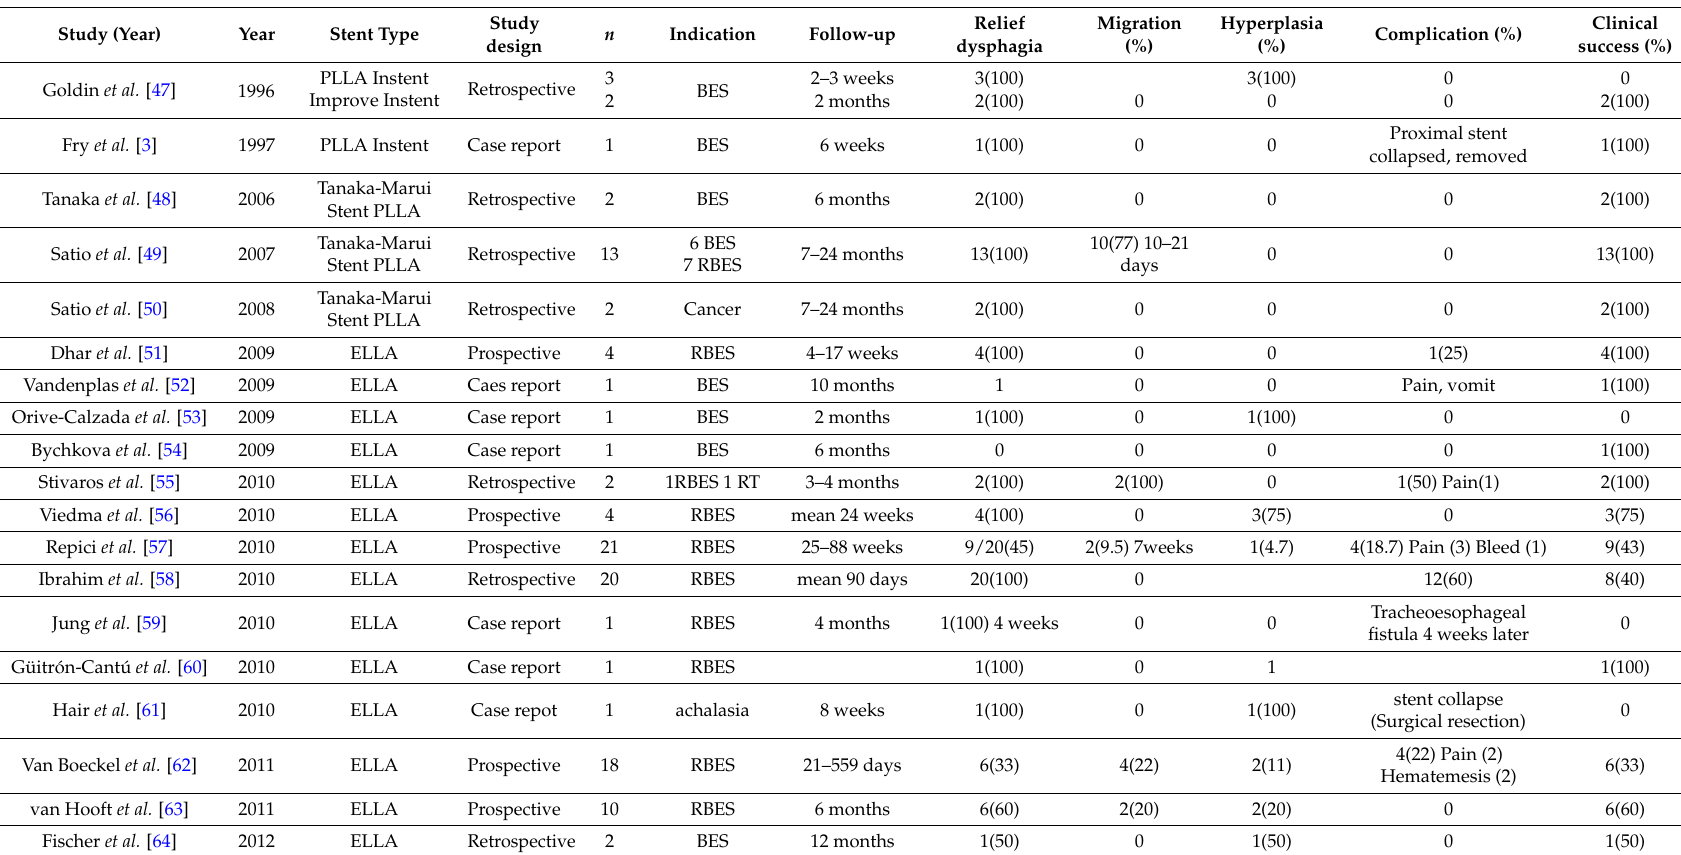
Table 1. Result of biodegradable stents in esophageal